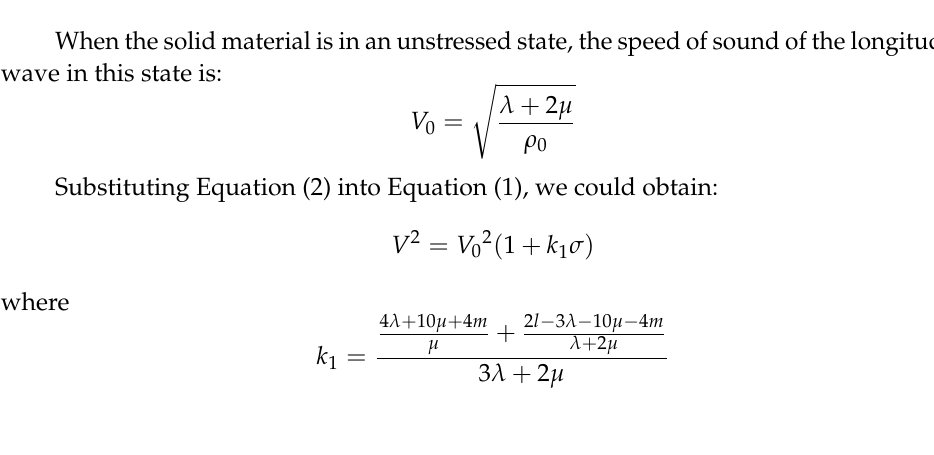
Table 1. Second-order and third-order constants of aluminum alloy.